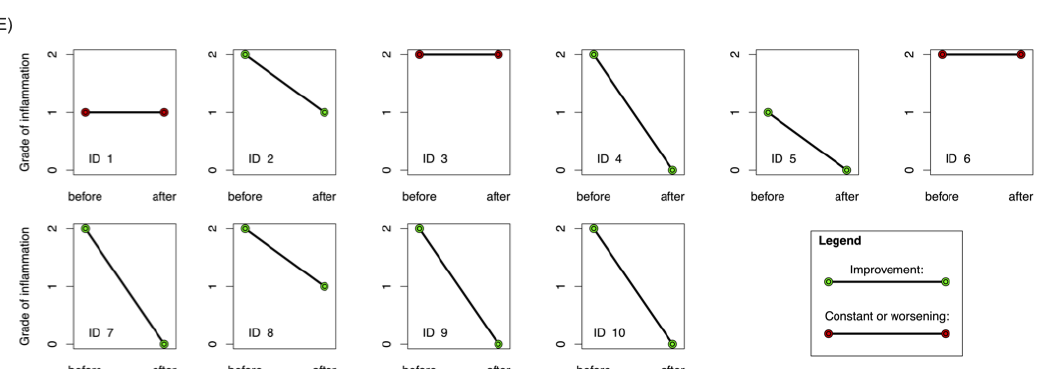
Figure 7. Patients with HHV6 DNA-associated myocarditis treated with steroid-based immunosup- pression. ( A ) Columns represent the New York Heart Association (NYHA) functional class distri- bution of the patients before and after treatment. Connected dots represent the individual changes in ( B ) left ventricular ejection fraction (LVEF), ( C ) LV-end-diastolic diameter (LVEDD), ( D ) HHV6 DNA copy numbers, and ( E ) grade of inflammation (defined as grade I: ≥ 14 leucocytes/mm 2 , ≥ 7 cells/mm 2 CD3-positive T-lymphocytes and grade II ≥ 28 leucocytes/mm 2 , treatment. N = 10. Statistically tested via paired t -test, * p < 0.05, ns: p ≥